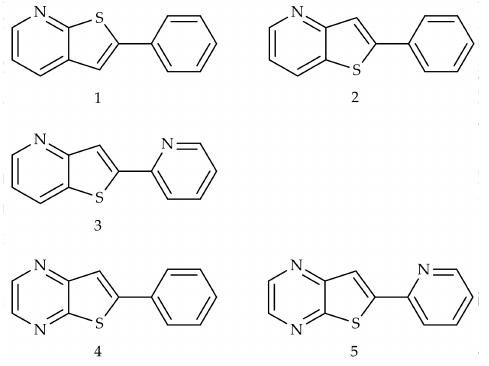
Figure 1. Thienopyridines and thienopyrazines used in first attempts of Pd-catalyzed direct arylation.